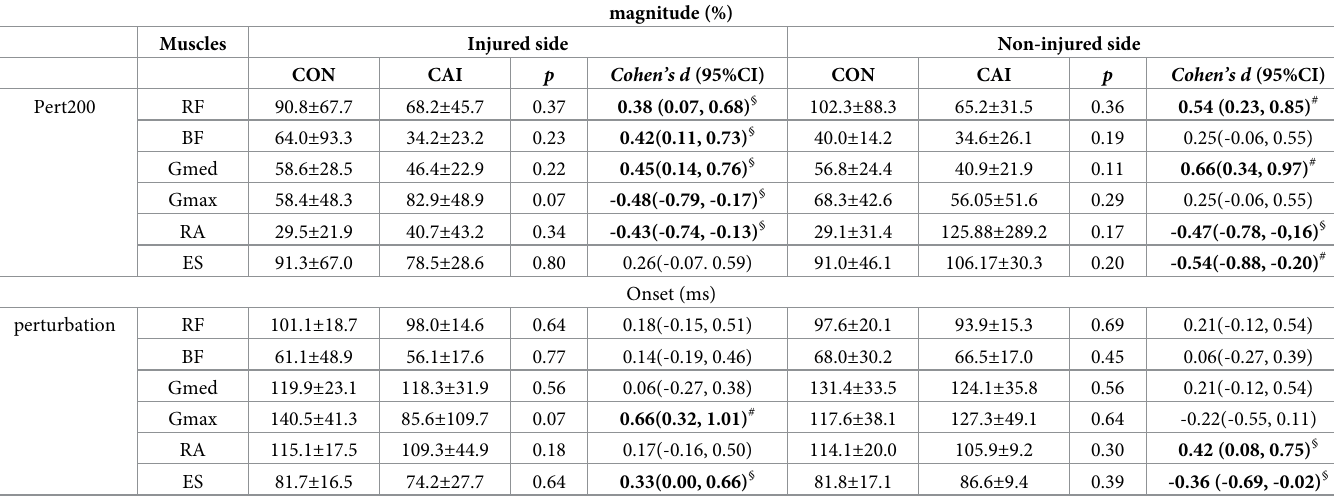
perturbed in the perturbed walking trail. CON: the matched control group, CAI: the group of chronic ankle instability, 95%CI: 95% of confident interval for Cohen’s d, � representing p < .05, ※ representing 95%CI did not cross zero with a large effect size, # representing 95%CI did not cross zero with a median effect size, § representing 95%CI did not cross zero with a small effect size